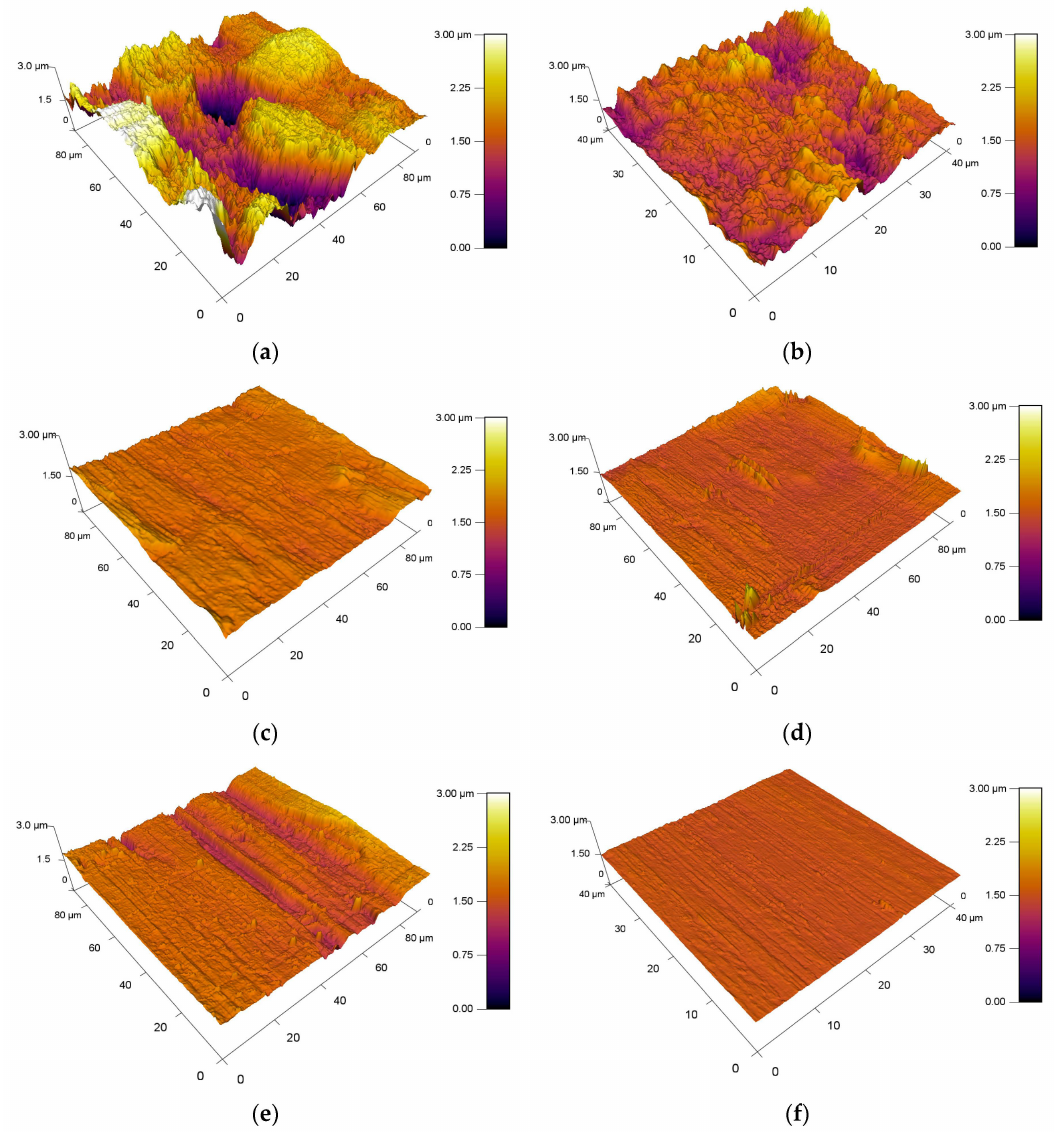
Figure 15. Evaluation of roughness of tested steel samples 90MnCrV8 at friction speed (m / s): ( a ) 0.2, ( b ) 0.4, ( c ) 0.6, ( d ) 0.8, ( e ) 1.0, ( f )